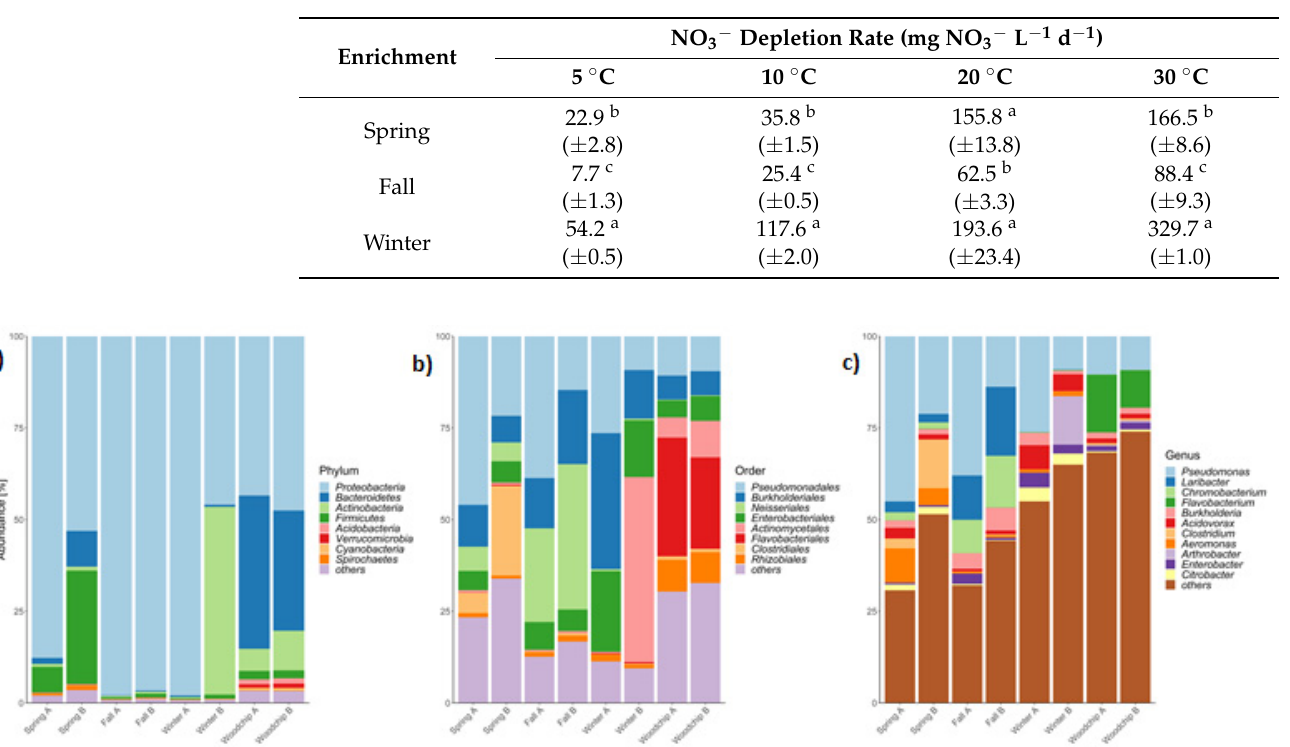
Table A3. Rates of nitrate (NO 3 − ) removal (mg L − 1 d − 1 ) in enrichments cultures from bioreactor woodchips sampled in three different seasons (spring, fall, winter). Data are means ± standard errors of four biological replicates, where different letters indicate differences at p < 0.05 among enrichments at the same temperature, as tested by a mixed linear model (on subsets of data by temperature). a stands for the highest depletion rate at a given temperature, b for the second highest significantly different from a , and c stands for the lowest depletion rate significantly different to a and b .